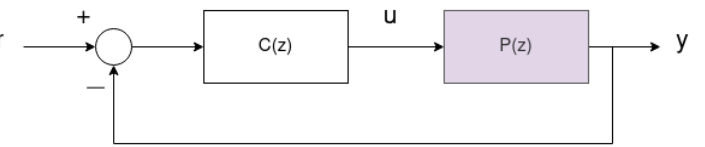
Figure 1. A feedback system with an unknown discrete-time plant, P ( z ) , and a discrete-time LTI controller, C ( z ) .